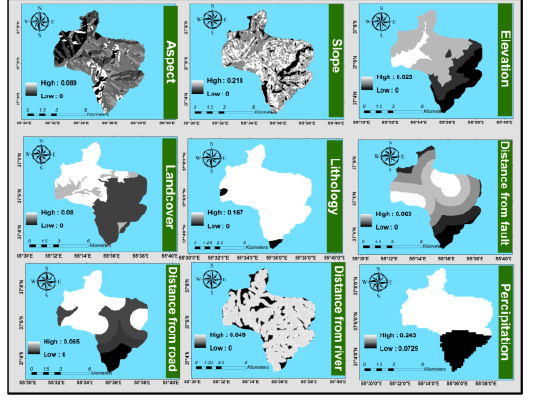
Figure 4. FAHP maps of input data layers